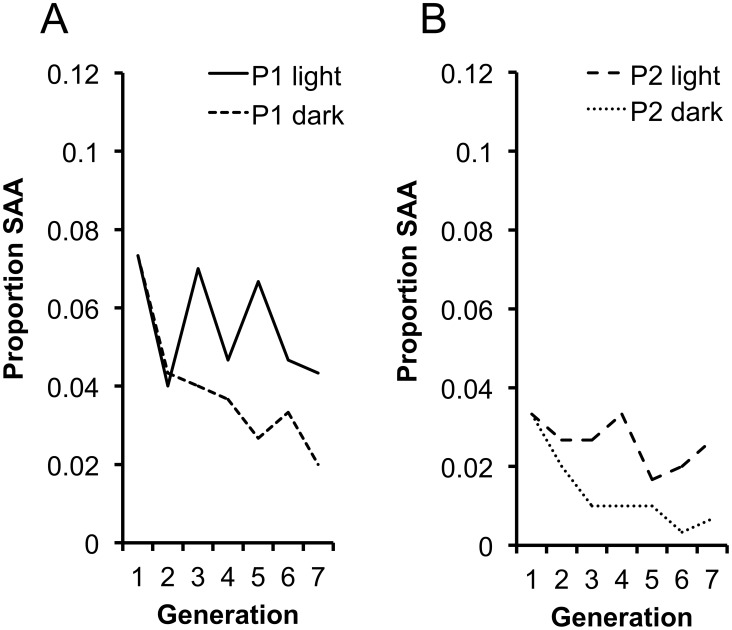
Changes in SAA frequency in the light and dark populations.SAA frequency was affected by the manipulation of light/dark regimes (χ2
1 = 18.82, p<0.0001) across (a) P1 light and dark populations and (b) P2 light and dark populations. There was a significant interaction between light treatment and generation (χ2
1 = 4.54, p = 0.033) showing that SAA frequency significantly diverged between the continuous light and continuous dark populations. SAA frequency did not significantly change in light populations (χ2
1 = 2.97, p = 0.085) but significantly declined in dark populations (χ2
1 = 4.81, p = 0.028).